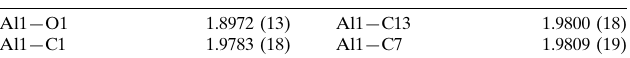
Selected bond lengths (A˚ ).